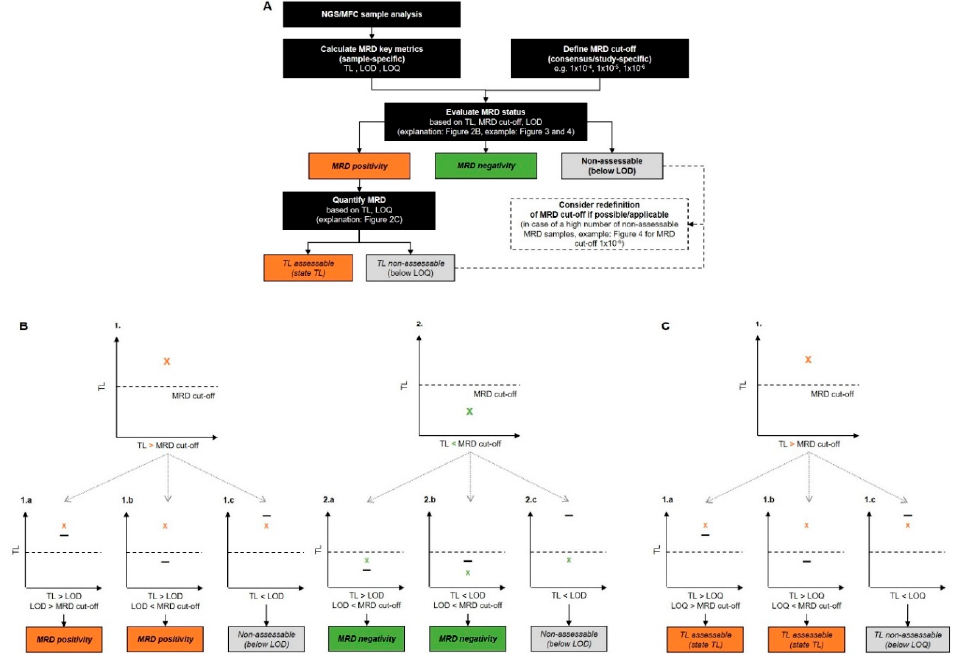
Figure 7. Data evaluation workflow for NGS and NGF MM MRD results. The general data